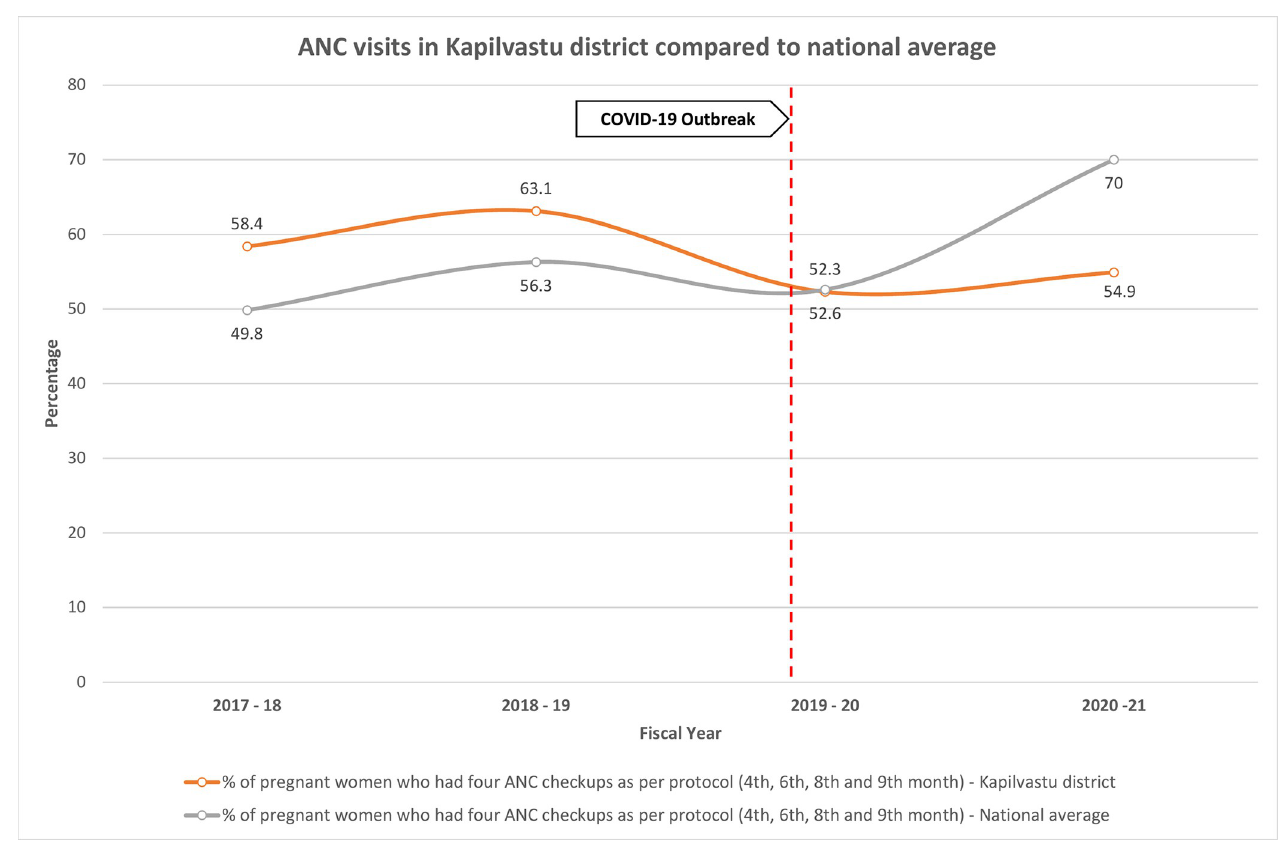
Fig 1. ANC visits in Kapilvastu district compared to national average.